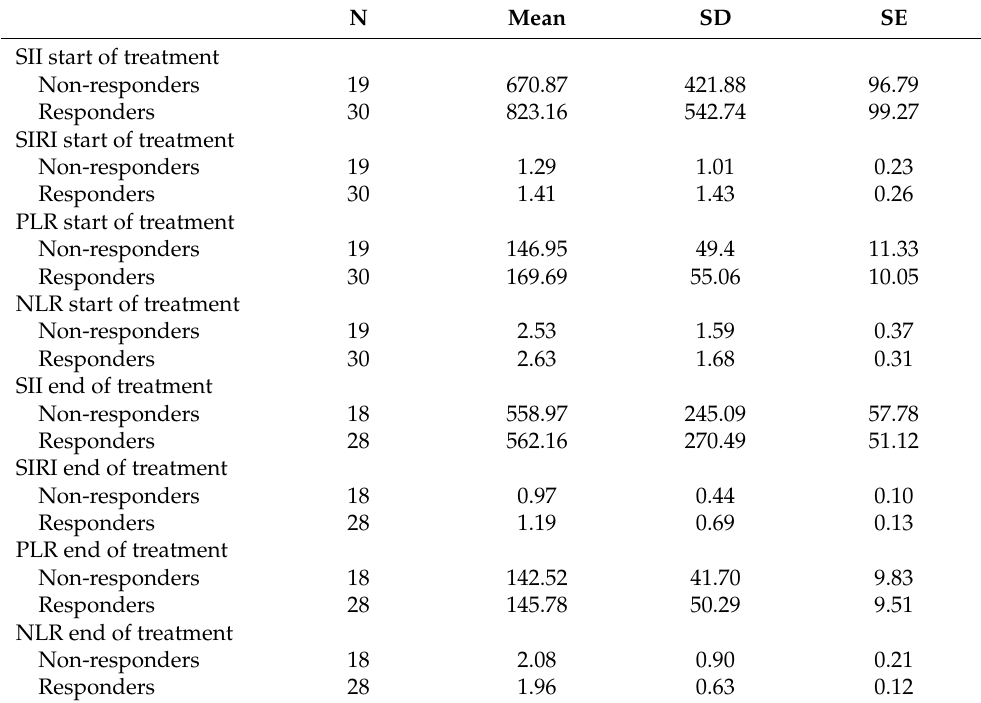
Table 3. Indicator values by group (responders vs.